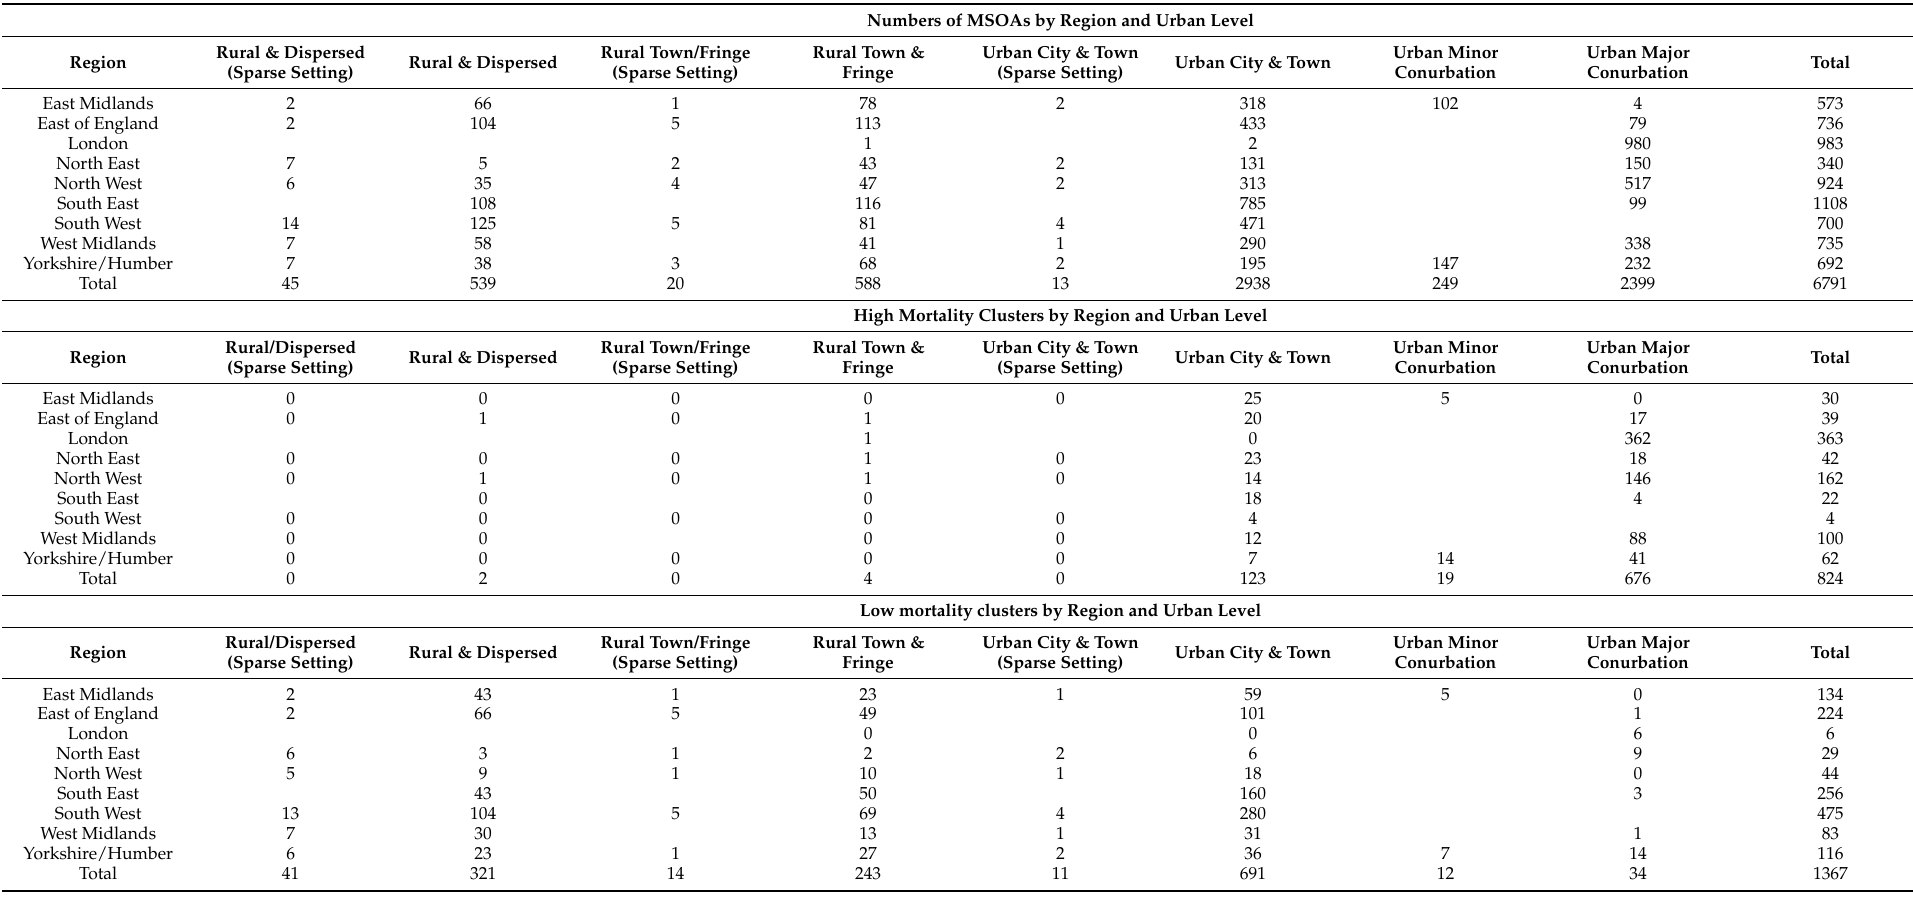
Table 4. COVID Mortality Clusters by Area